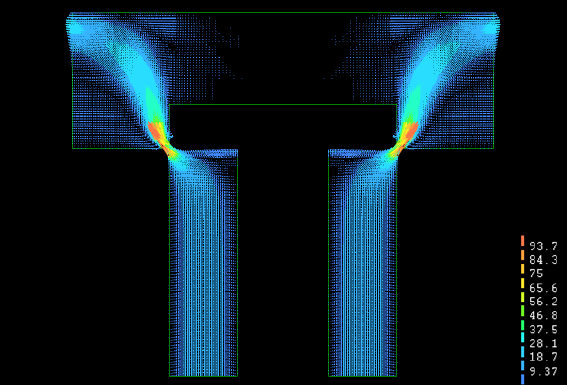
Fig. 14. Velocity profile of the modified design in the neutral mode with embodied outlet nozzles